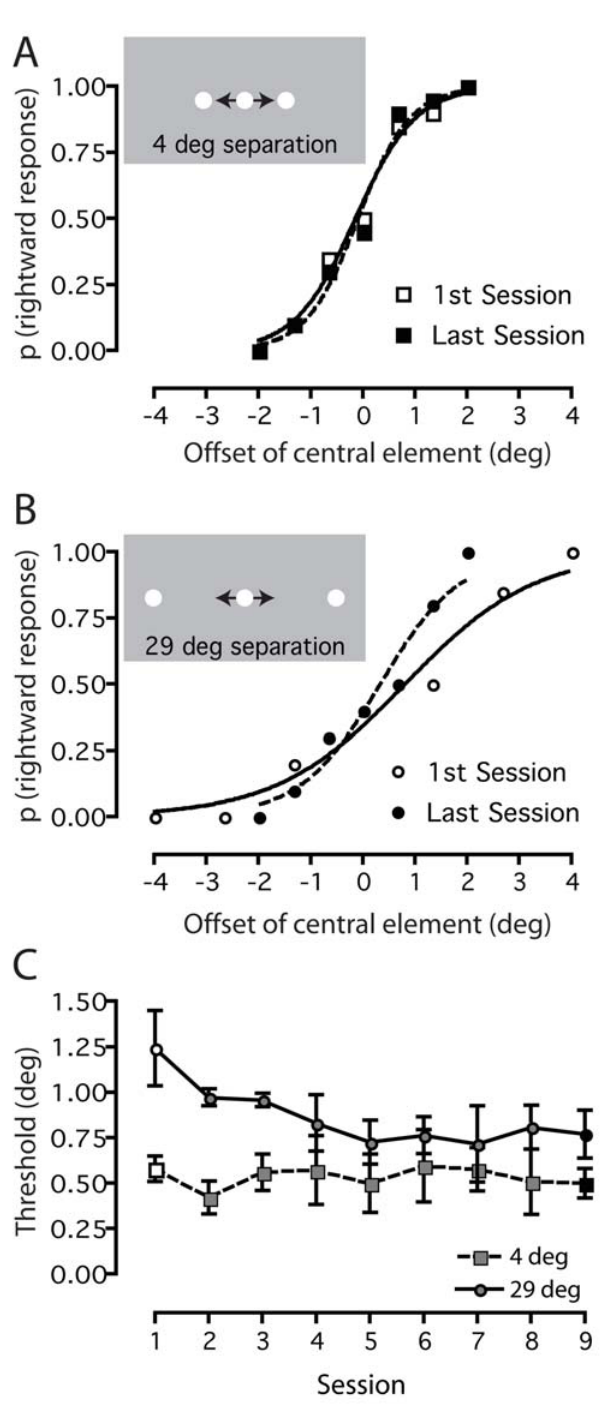
Figure 2. Quantifying positional learning. Example individual results are shown for a typical subject trained on the horizontal bisection task. a) A comparison of psychometric functions obtained on the first and last day reveals negligible learning at the smallest stimulus separation (4 deg). b) In contrast, a noticeable steepening of the psychometric function is evident at the largest stimulus separation (29 deg), indicating a learned improvement in task performance. c) Positional thresholds derived from the individual’s psychometric functions, plotted as a function of session for the two extreme stimulus